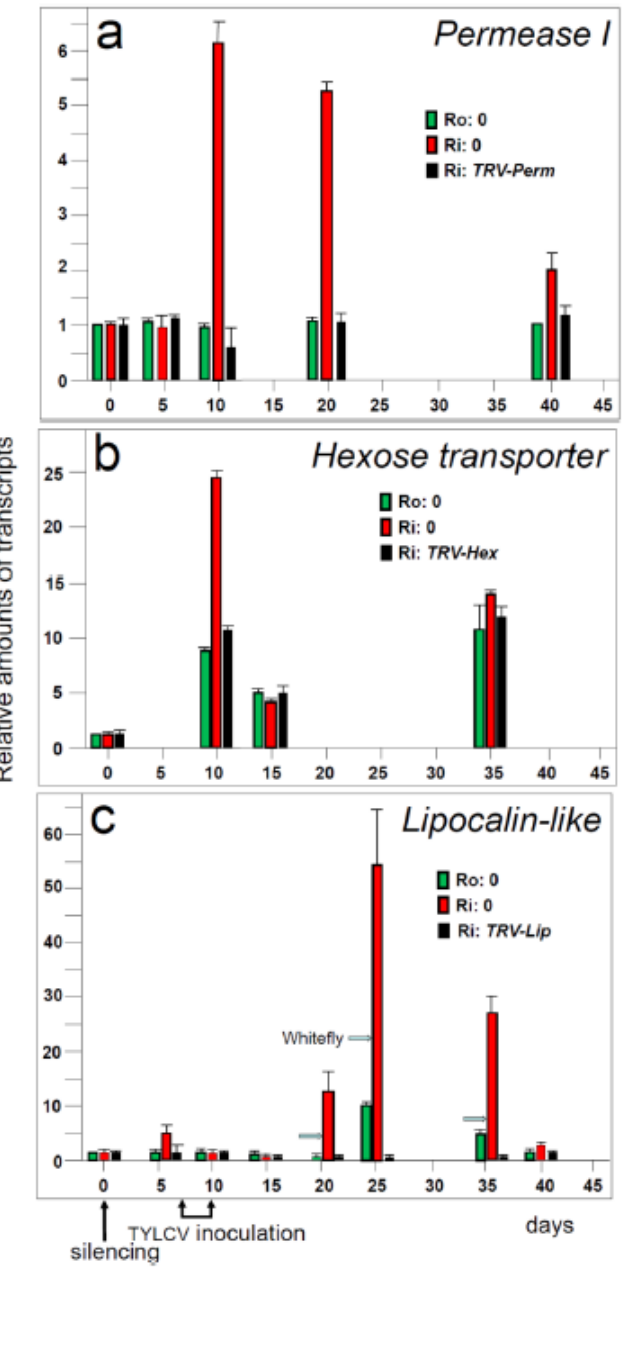
Figure 4. Relative amounts of transcripts of Permease I , Hexose transporter LeHTe1 , and Lipocalin-like genes in R tomato plants (Ro:0), infected R tomato plants (Ri:0) and infected R tomato plants with silenced Permease I (Ri: TRV-Perm ), Hexose transporter LeHTe1 (Ri: TRV-Hex ), and Lipocalin-like (Ri: TRV-Lip ) genes. Tubulin RNA was used as a reference gene transcript for each of the plants analyzed by qPCR. The amount of transcript immediately before silencing (at day 0) is taken as 1. Average of triplicate measures of three different plants. Bars: standard